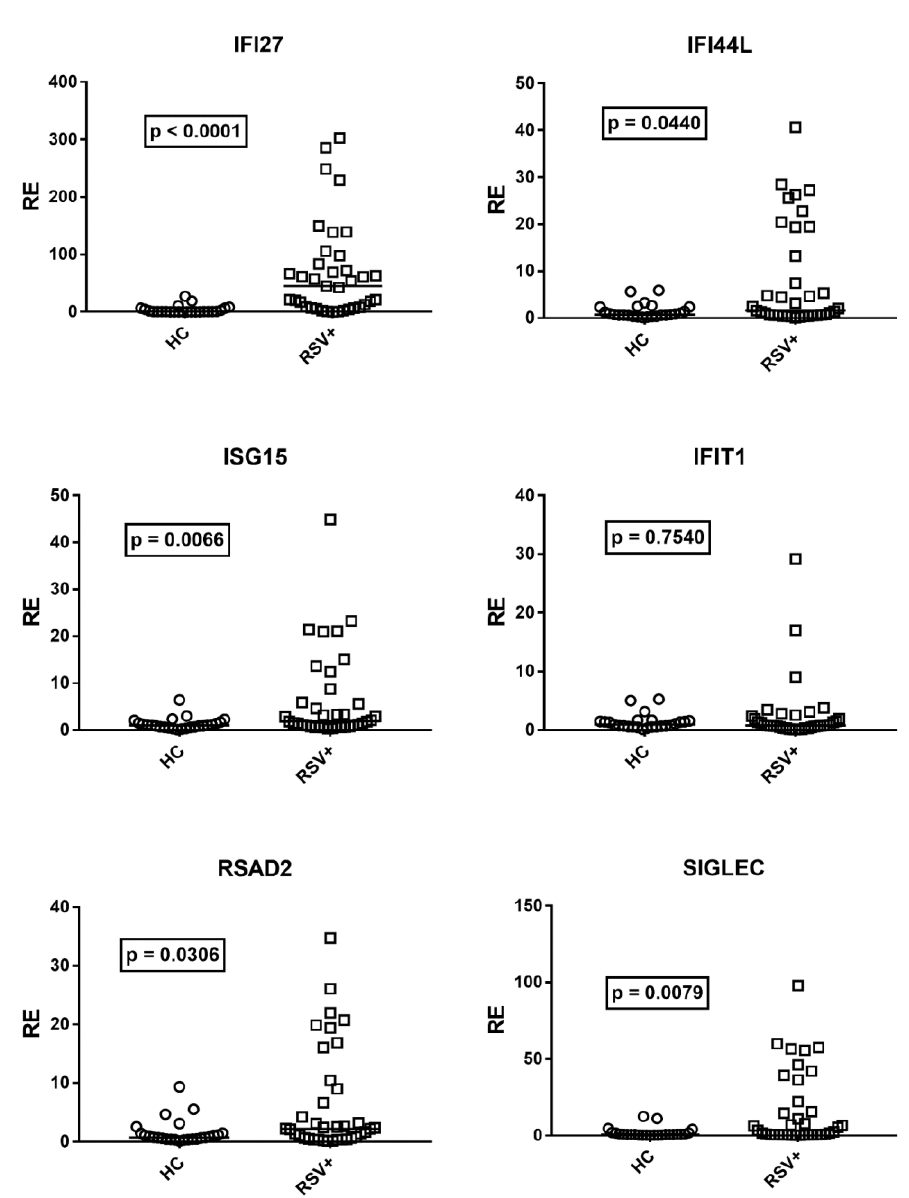
Figure 2. Expression of type I interferon stimulated genes (ISGs) in whole blood from 37 children with acute RSV bronchiolitis (RSV+) and 25 age-matched healthy children (HC). RE: relative expression. Circles and squares show the mean of three individual measurements; horizontal lines show the median values. Median values and interquartile range 25–75% of ISGs: IFI27: HC 0.55, 0.31–4.60; RSV+ 44.98, 7.90–83; IFI44L: HC 0.72, 0.54–2.36; RSV+ 1.59, 057–13.23; ISG15: HC: 1.02, 0.62–1.50; RSV+ 1.85, 0.78–5.89; IFIT1: HC 0.97, 0.59–1.49; RSV+ 0.79, 0.48–1.91; RSAD2: HC 0.76, 0.46–1.45; RSV+ 2.21, 0.66–9.02; SGLEC: HC 0.73, 0.48–1.63; RSV+ 3.43, 0.68–22.05. Statistical analysis: Mann–Whitney test was used to compare values of each group of children with each